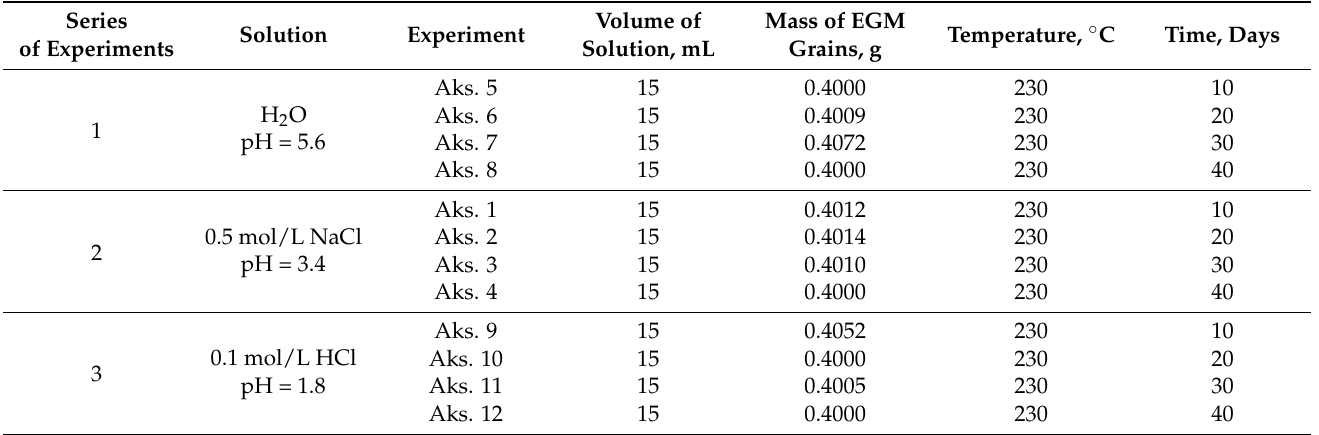
Table 2. Experimental